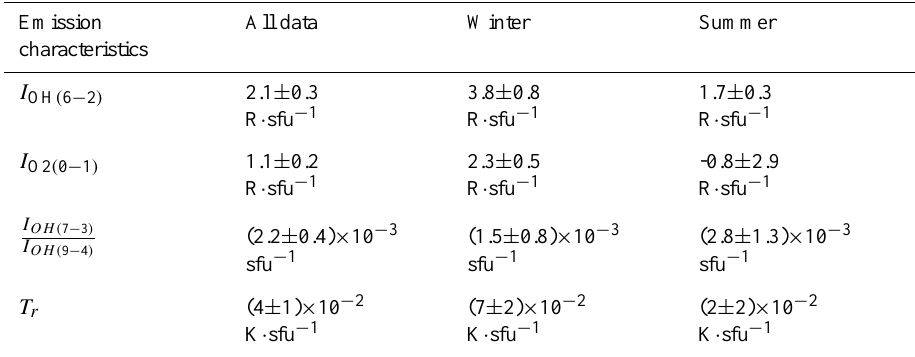
Table 2. Slope coefficient of the regression line T r (F 10 . 7 )